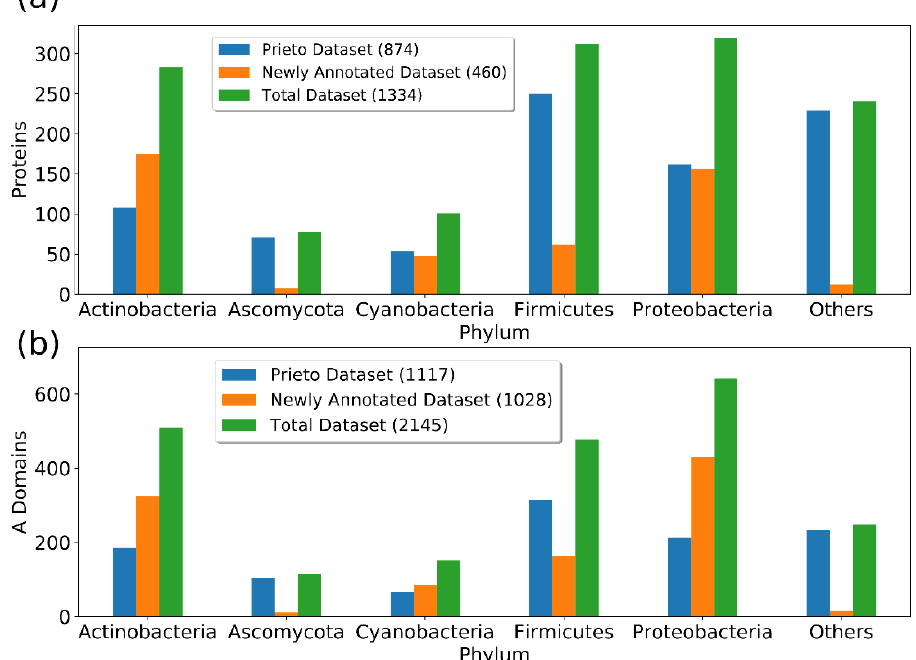
Figure 2. Phylogenetic composition of the A-domain training dataset. The composition is shown for each protein ( a ) and all the A-domains ( b ). Almost all fungi sequences can be attributed to the phylum of ascomycota. The division of others comprises domains where no taxonomy could be found or small groups, such as streptophyta (No. 6) , candidatus tectomicrobia (No. 5), and arthropoda (No. 3).